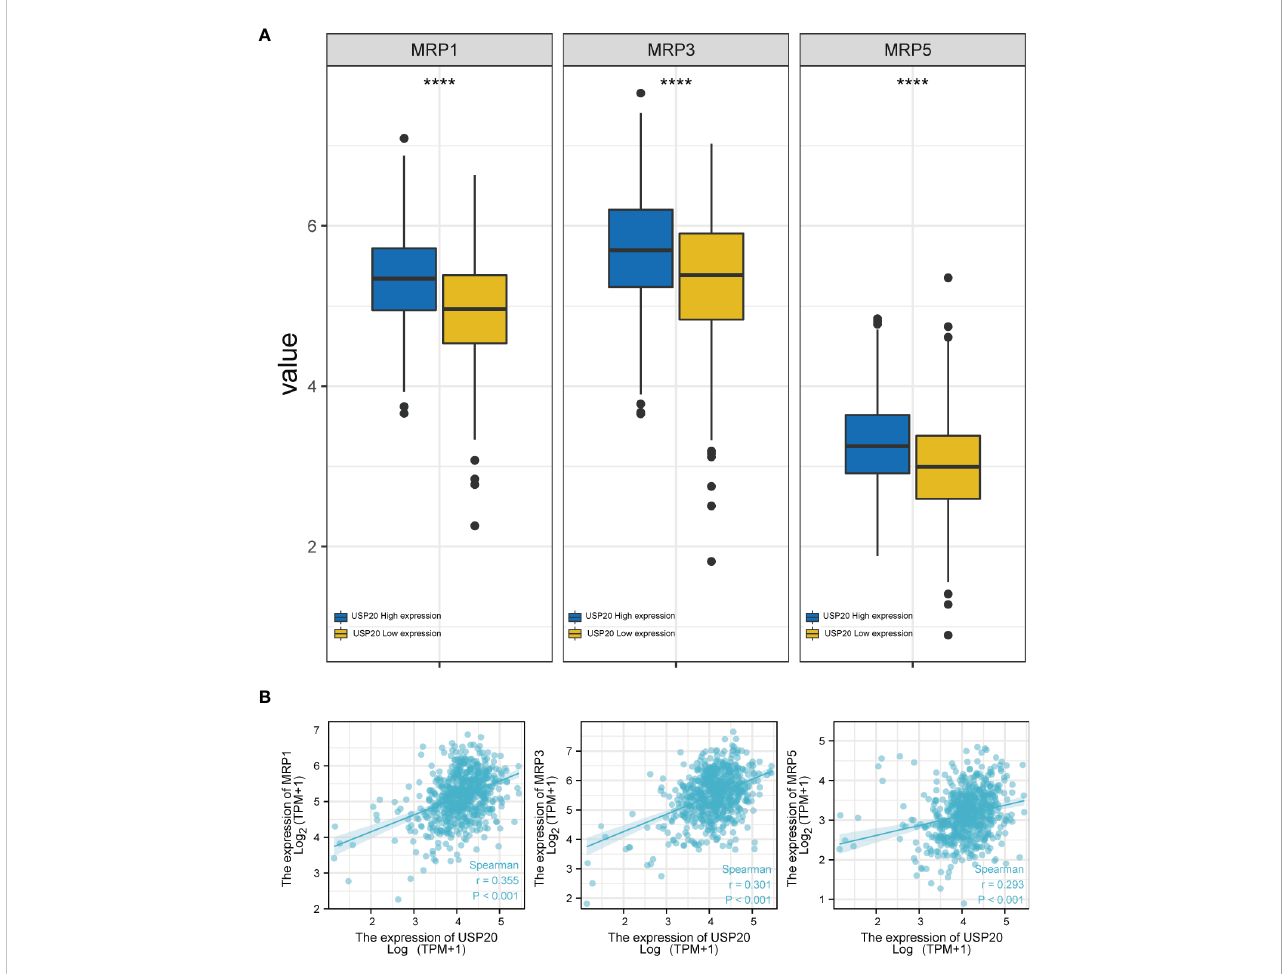
FIGURE 6 The relationship between anti-tumor drug genes and USP20 expression group; (A) Expression of anti-tumor drug genes (MRP1, MRP3, MRP5) in different USP20 expression CRC group; (B) The co-expression analysis between USP20 and anti-tumor drug genes (MRP1, MRP3, MRP5) in CRC; (*P < 0.05; **P < 0.01; ***P < 0.001; ****P < 0.0001; NS, not signi fi